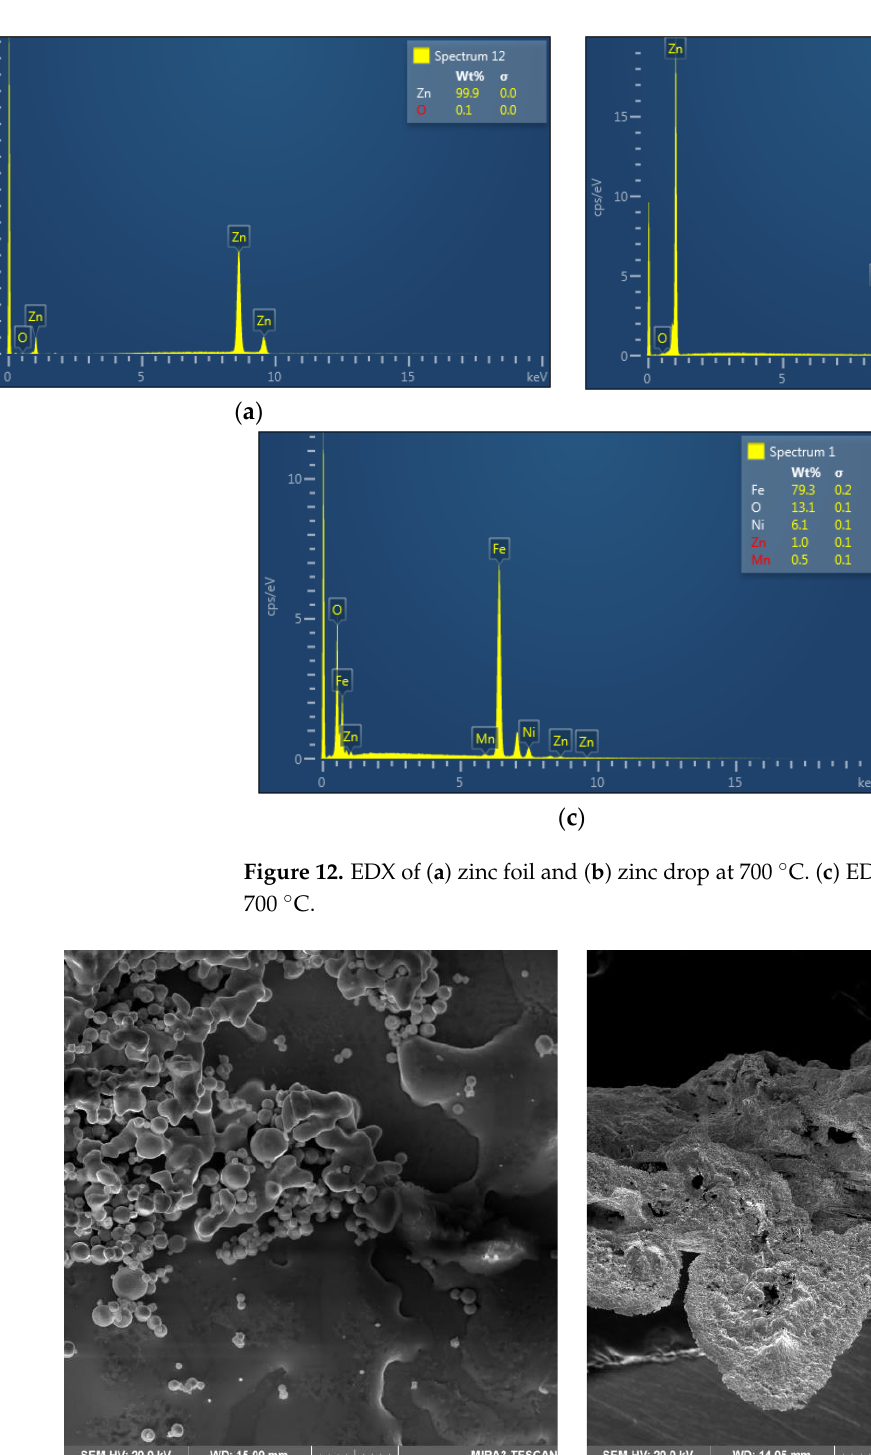
( b ) Figure 11. Morphology of the residue after the evaporation process under the temperature of 700 °C at at (a) 500 µm magnification and (b) 5 µm magnification.